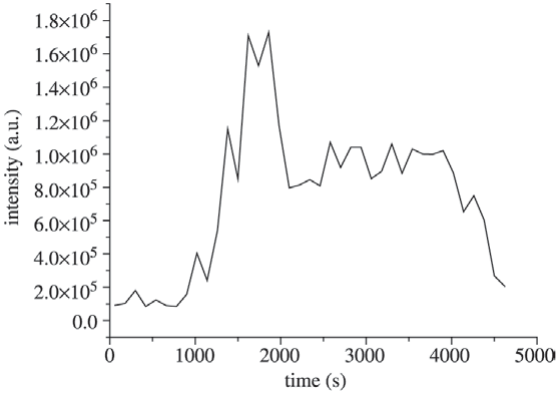
Figure 5. Integrated intensity plot for the peak at 2 θ =